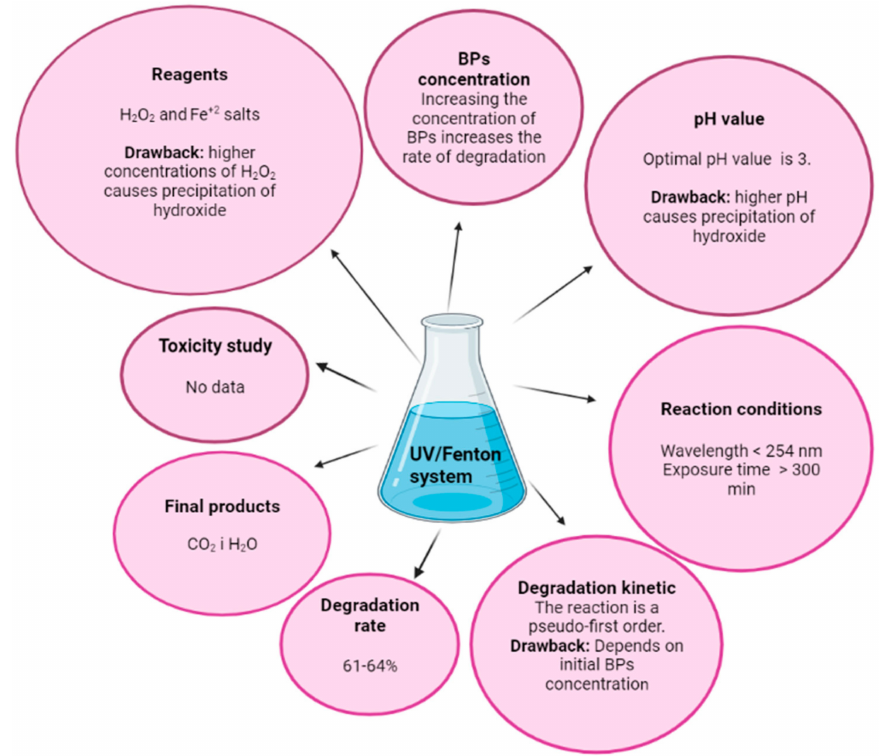
Figure 4. An overview of the effect of different conditions in the UV/Fenton process on the degradation process of BPs. Created in